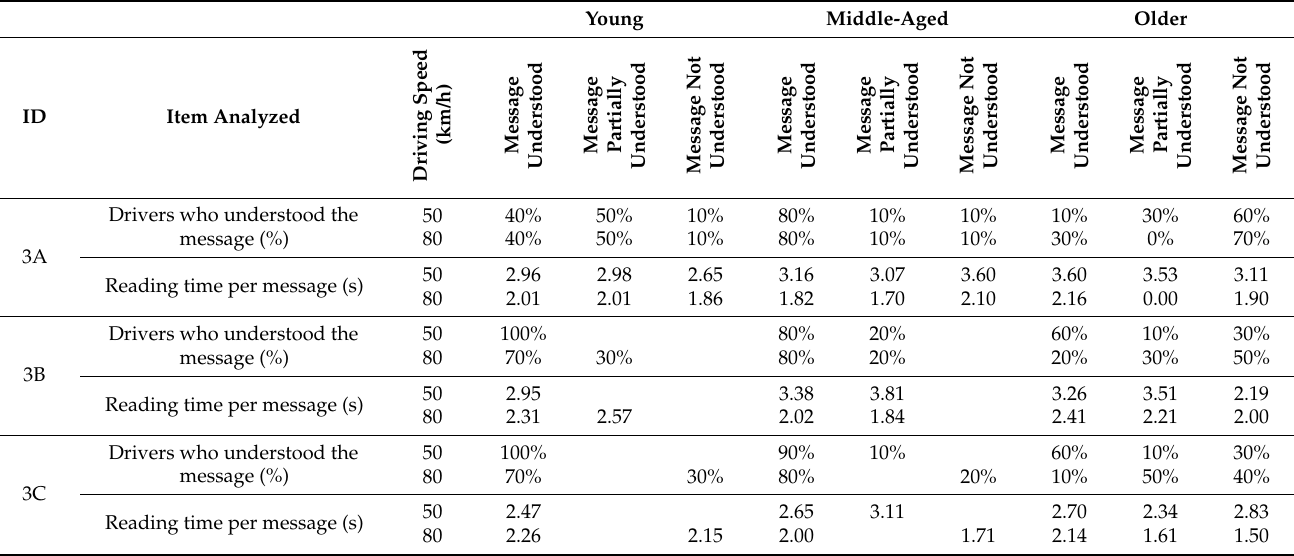
Table 6. Numerical results for Group 3—use of unfamiliar